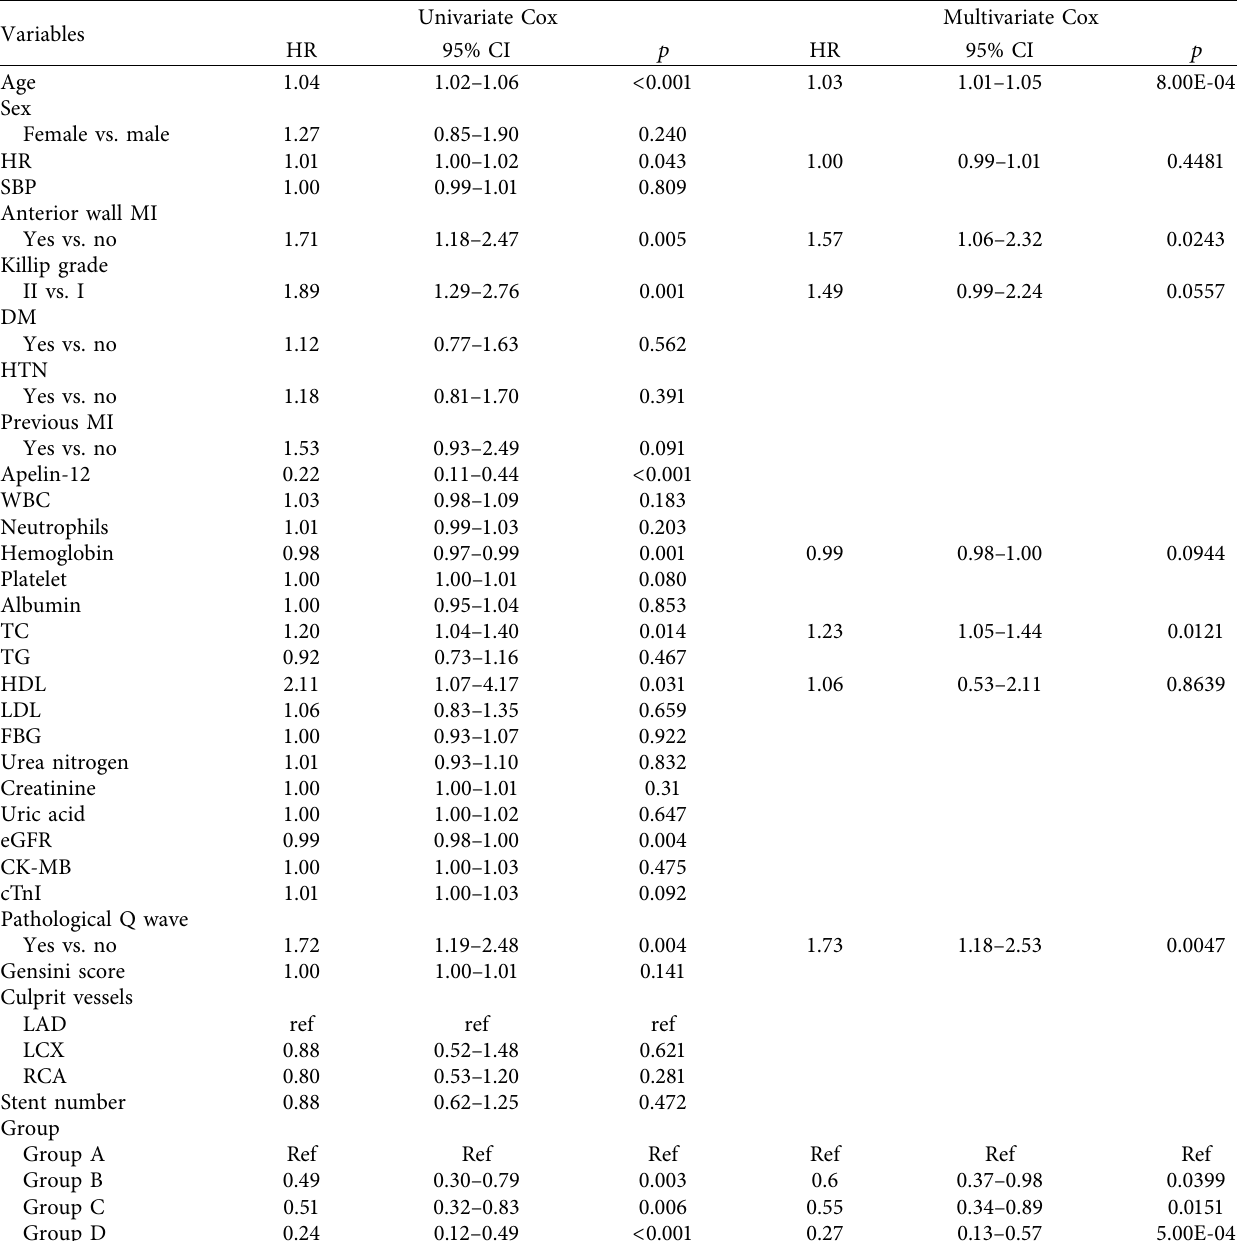
Table 2: Univariate and multivariate Cox